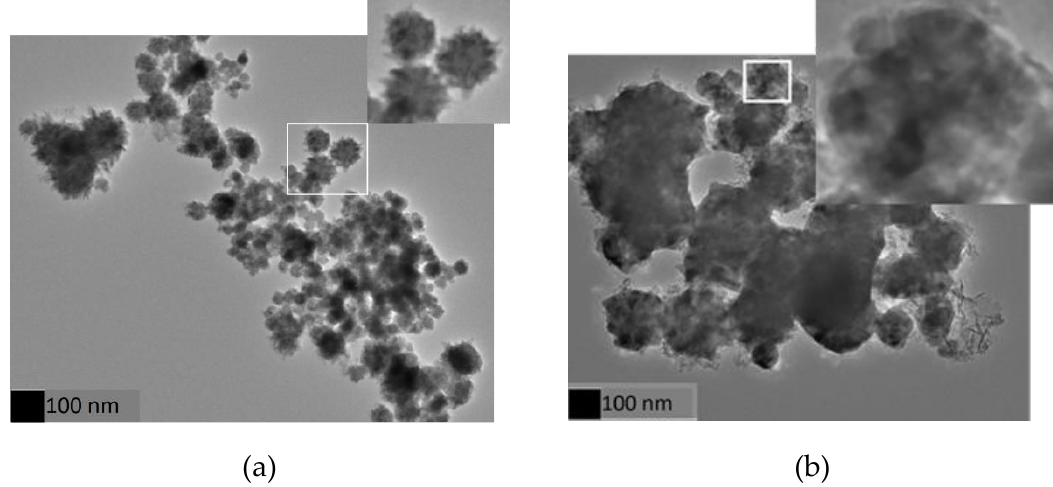
Figure 2. TEM image of the Ni x Cu 4 − x nanoparticles revealing the formation of nanoclusters for ( a ) the as-made and ( b ) the annealed samples. Nanomaterials 2019 , 9 , x FOR PEER REVIEW